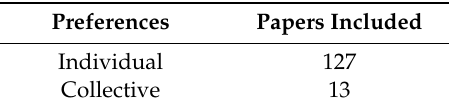
Table 5. Type of preferences.